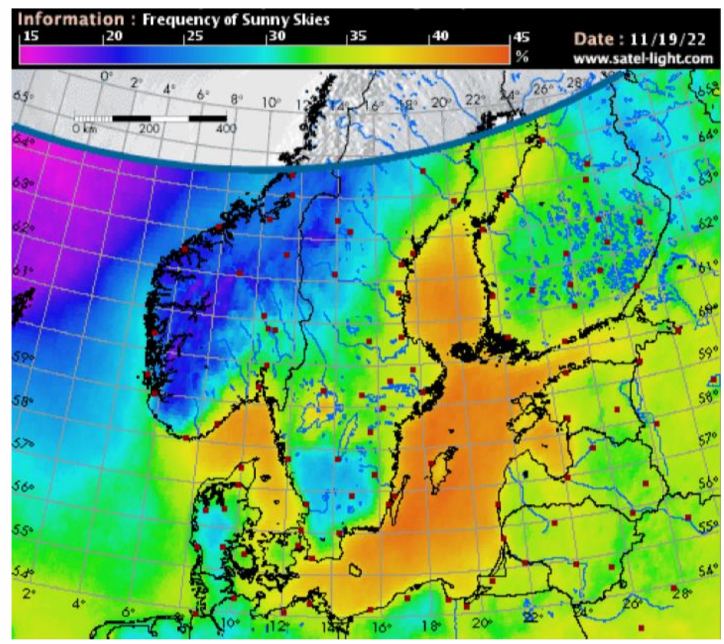
Figure 1. Frequency of sunny skies in Northern Europe (image taken from [37] with the permission of Barbara